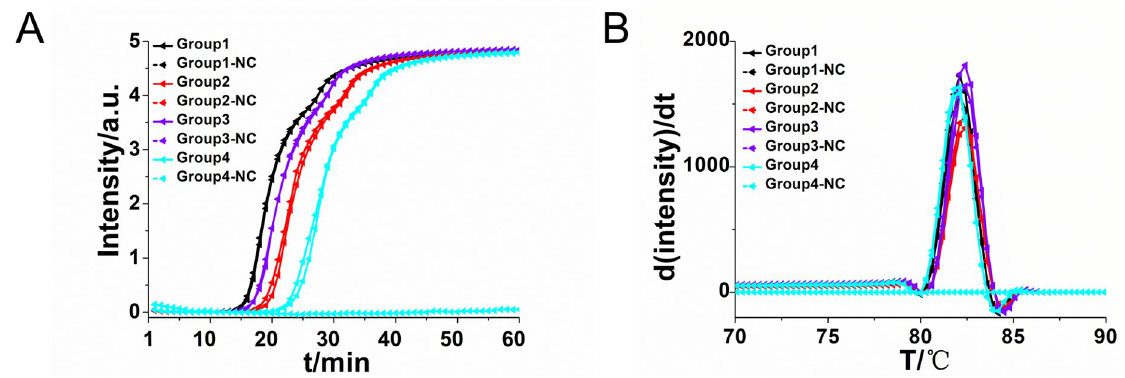
Fig 2. Amplifications of R . raoultii DNA by R-CDA monitored by real-time PCR carried out at 60˚C for 60 min. (A) Real-time R-CDA of different groups for R . raoultii DNA (each set 2 positive reactions and 2 negative reactions). (B) Melting curve analysis of R-CDA products by real-time PCR. NC, negative control reaction without the template.